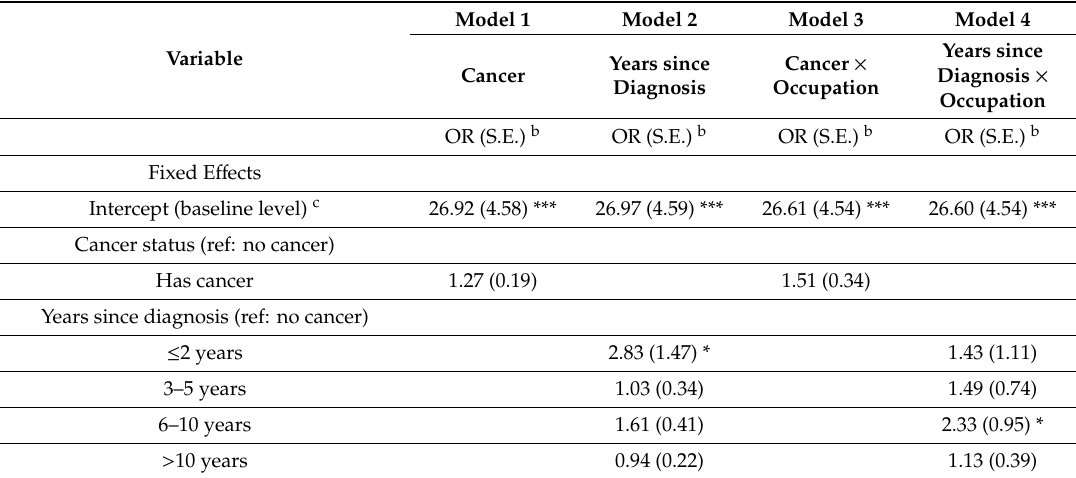
Table 2. Cancer and Employment Status among Women a